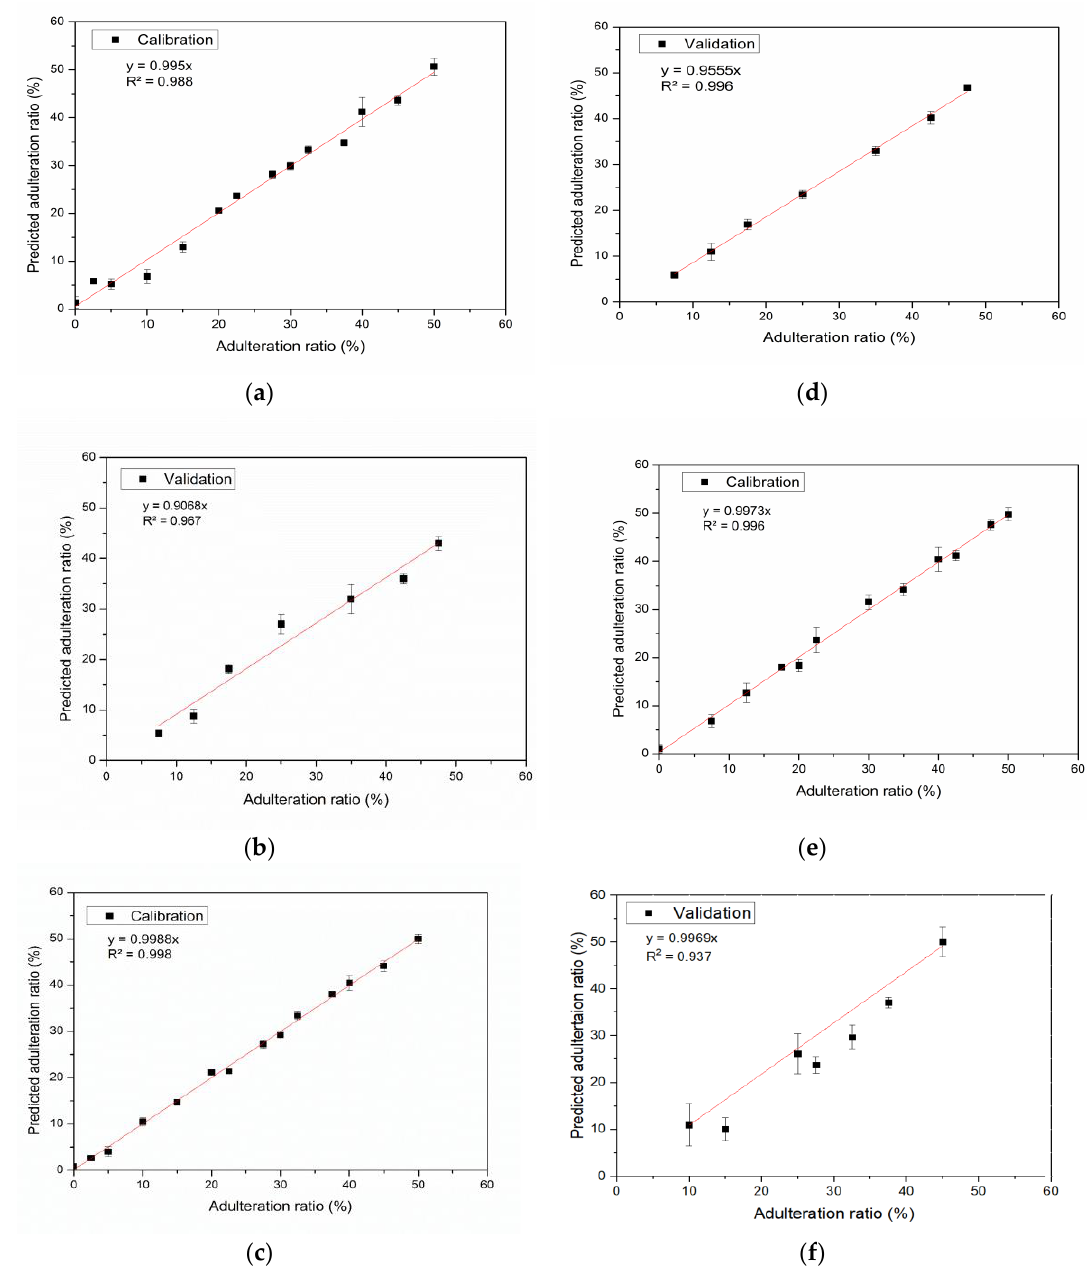
Figure 4. Calibration and validation data curves for grape ( a , b ), carob ( c , d ) and mulberry ( e , f ) pekmez samples.